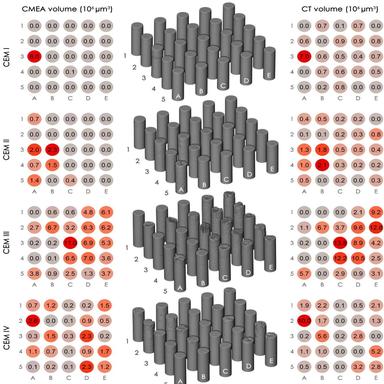
The volume of corrosion damage measured using the CMEA technique (left) compared to that evaluated using the microCT scanner (right). Middle column shows volumetric visual representation of corrosion damage obtained using microCT.